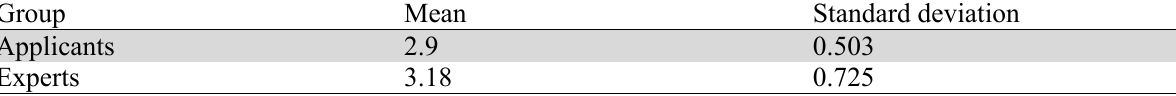
Descriptive statistics of opinions to investigate achieving economic goals Group